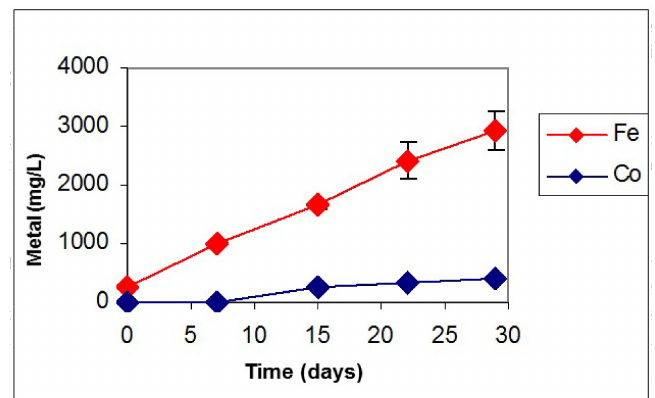
Figure 2. Laboratory-scale solubilisation of iron and cobalt from cobaltiferous pyrite present in mine tailings at Kasese, Uganda due to bioleaching by a consortium of acidophilic micro-organisms. The symbols depict the mean values of triplicate shake flasks and the error bars (where visible) standard